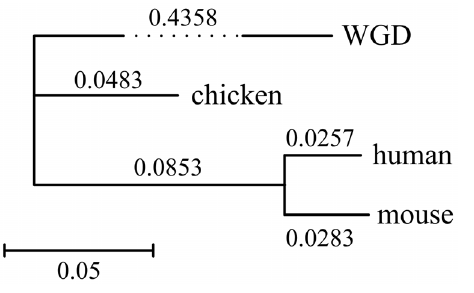
Figure 7. DCJ distance-based NJ tree of human, chicken, mouse and their WGD ancestor.